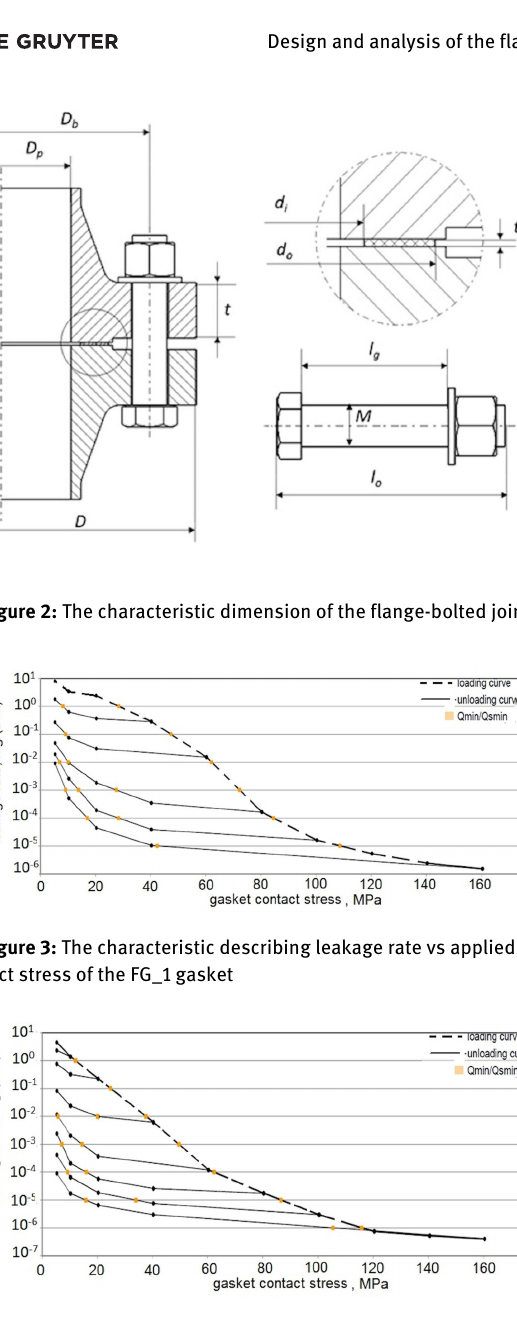
Figure 4: The characteristic of FG_2 gasket describing the leakage level as a function of contact stress